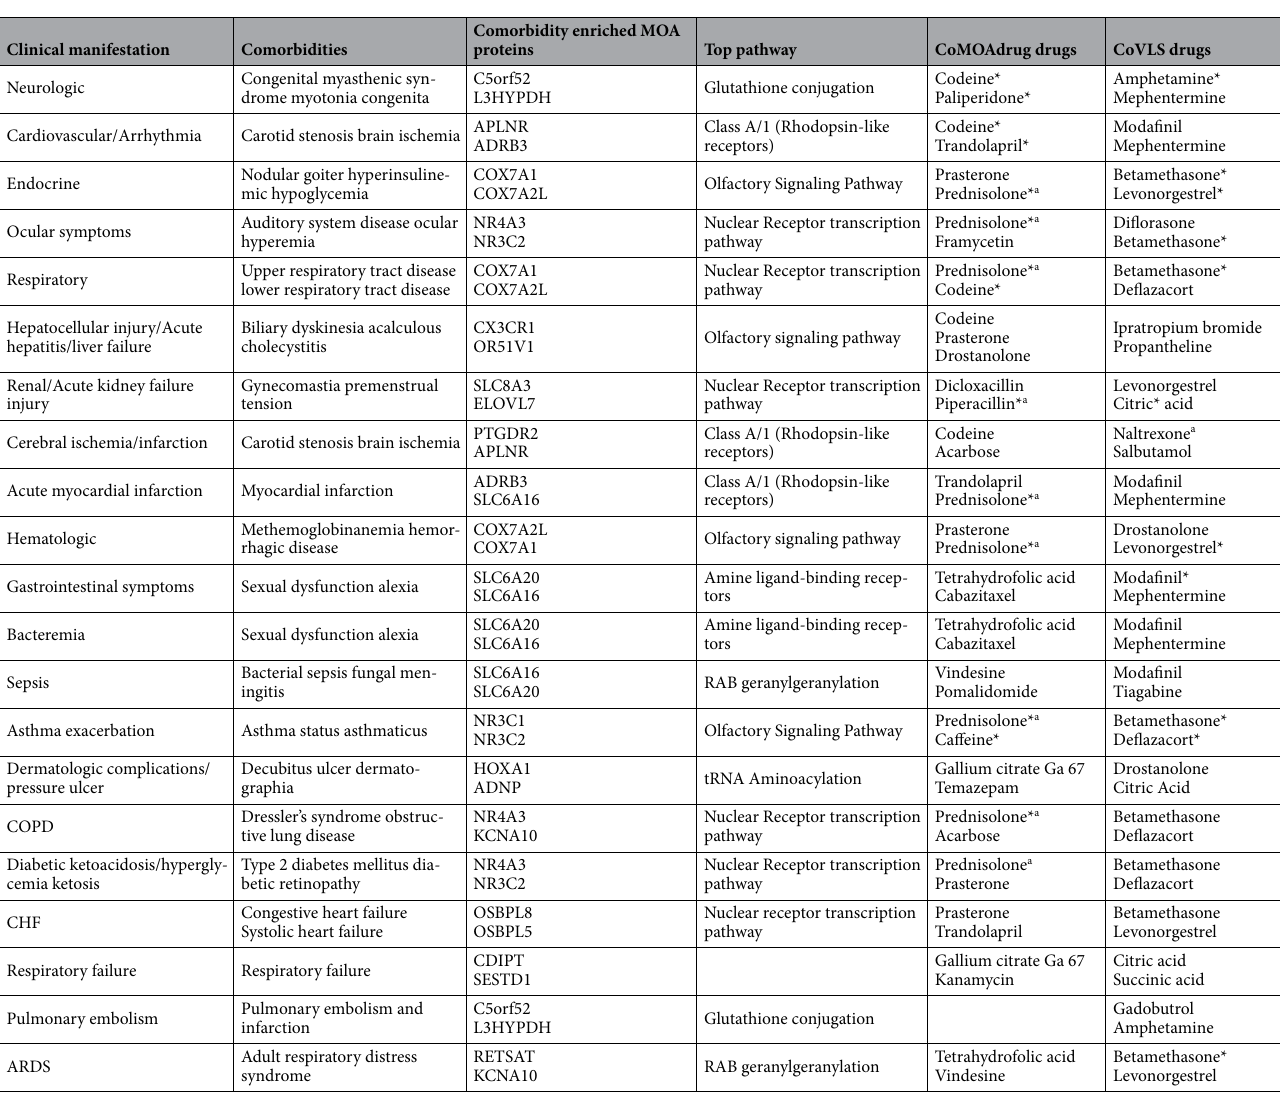
Table 2. Top 2 comorbidities, comorbidity enriched MOA proteins, top pathway, and top 2 repurposed FDA drugs predicted to treat specific COVID-19 severe adverse clinical manifestations using GWAS input. See Table 1 for details. The top 20 list of comorbidity ranked drugs are in SI, Table S2. *Indicates the drug is currently undergoing clinical trials for the COVID-19 complication in column 1. a Are drugs under trial for a general COVID-19